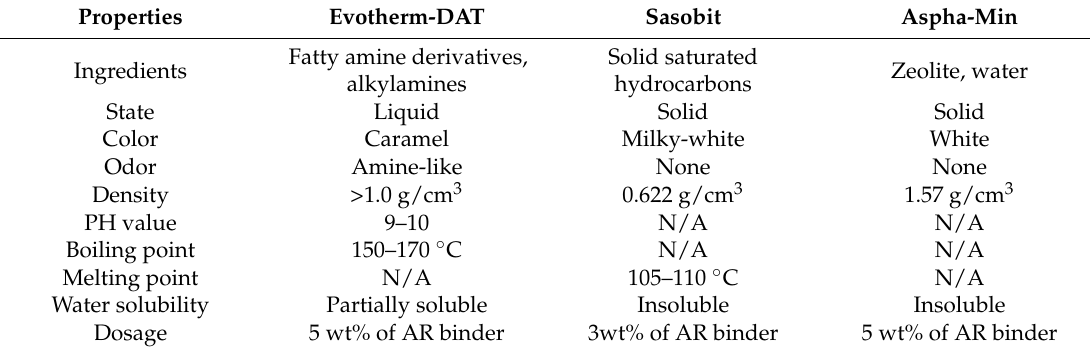
Table 1. Physical properties of selected warm mix asphalt (WMA)